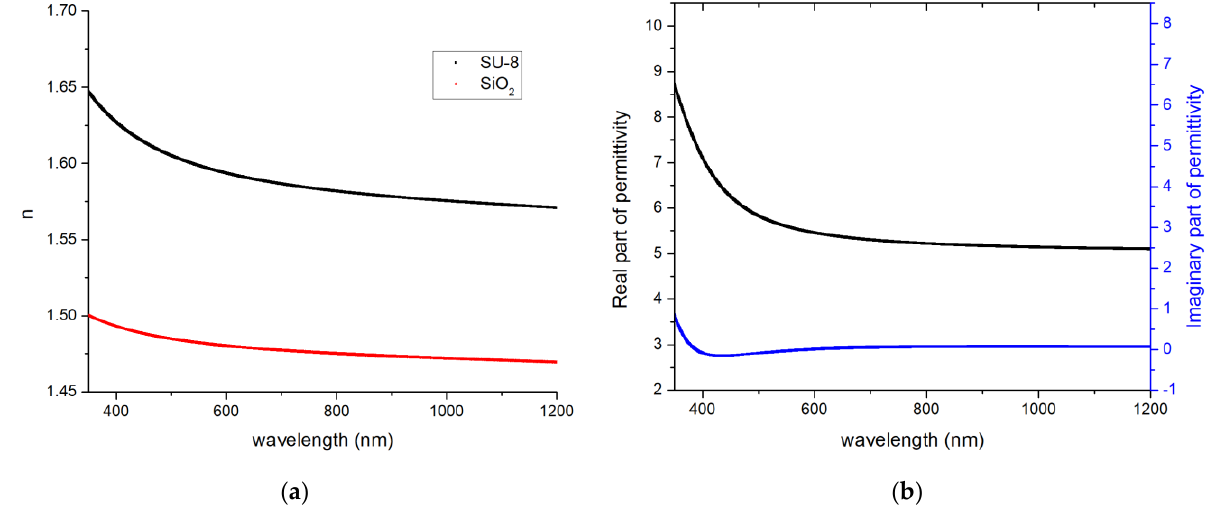
Figure 2. Dispersion curves: ( a ) transparent SU-8 and SiO 2 ; ( b ) absorbing TiO 2 .